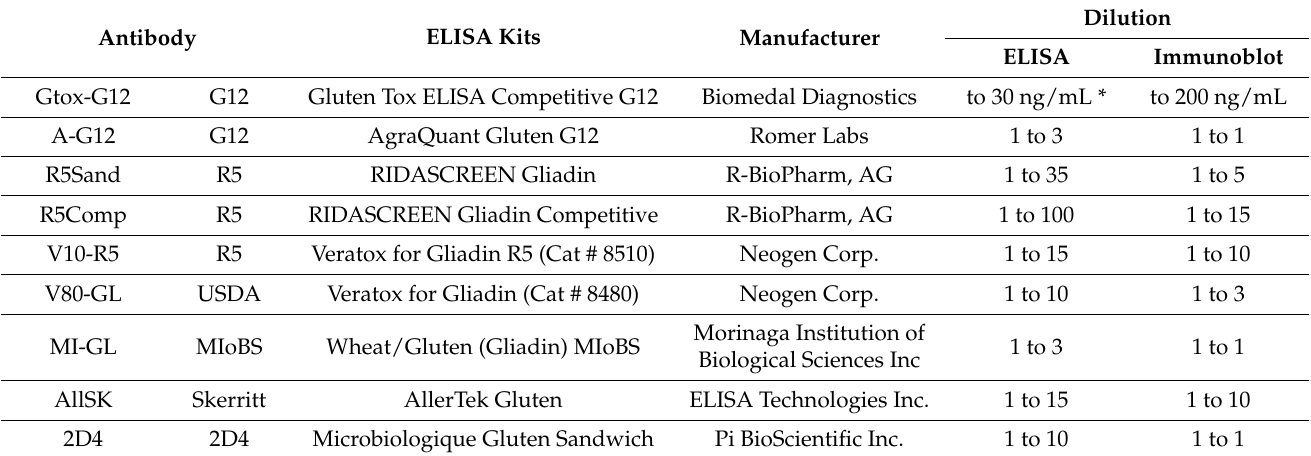
Table 1. HRP-conjugated antibodies from commercial ELISA kits in this